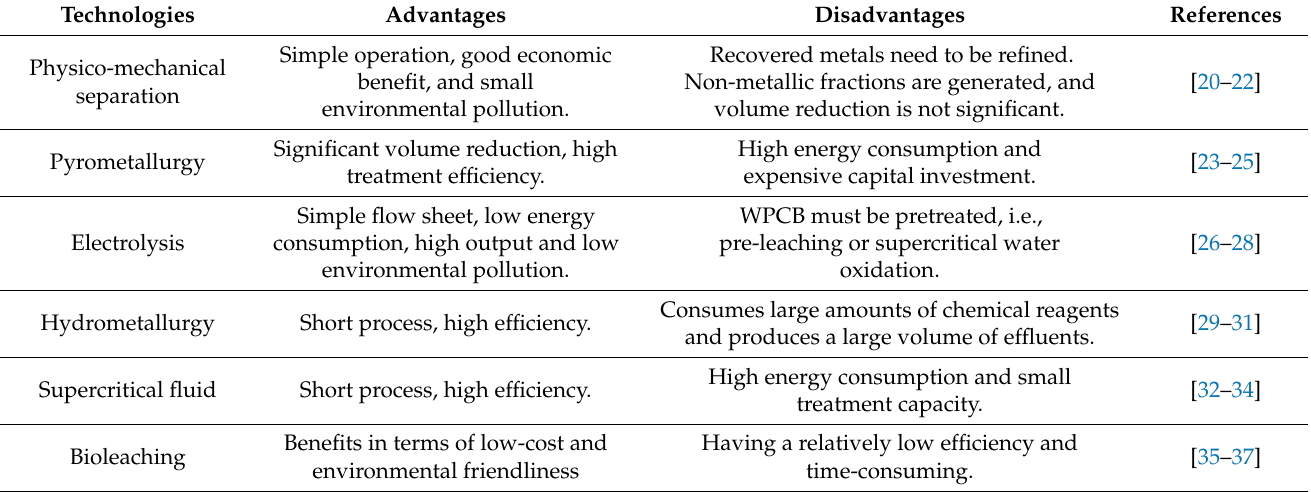
Table 1. The comparison of different technologies of WPCB